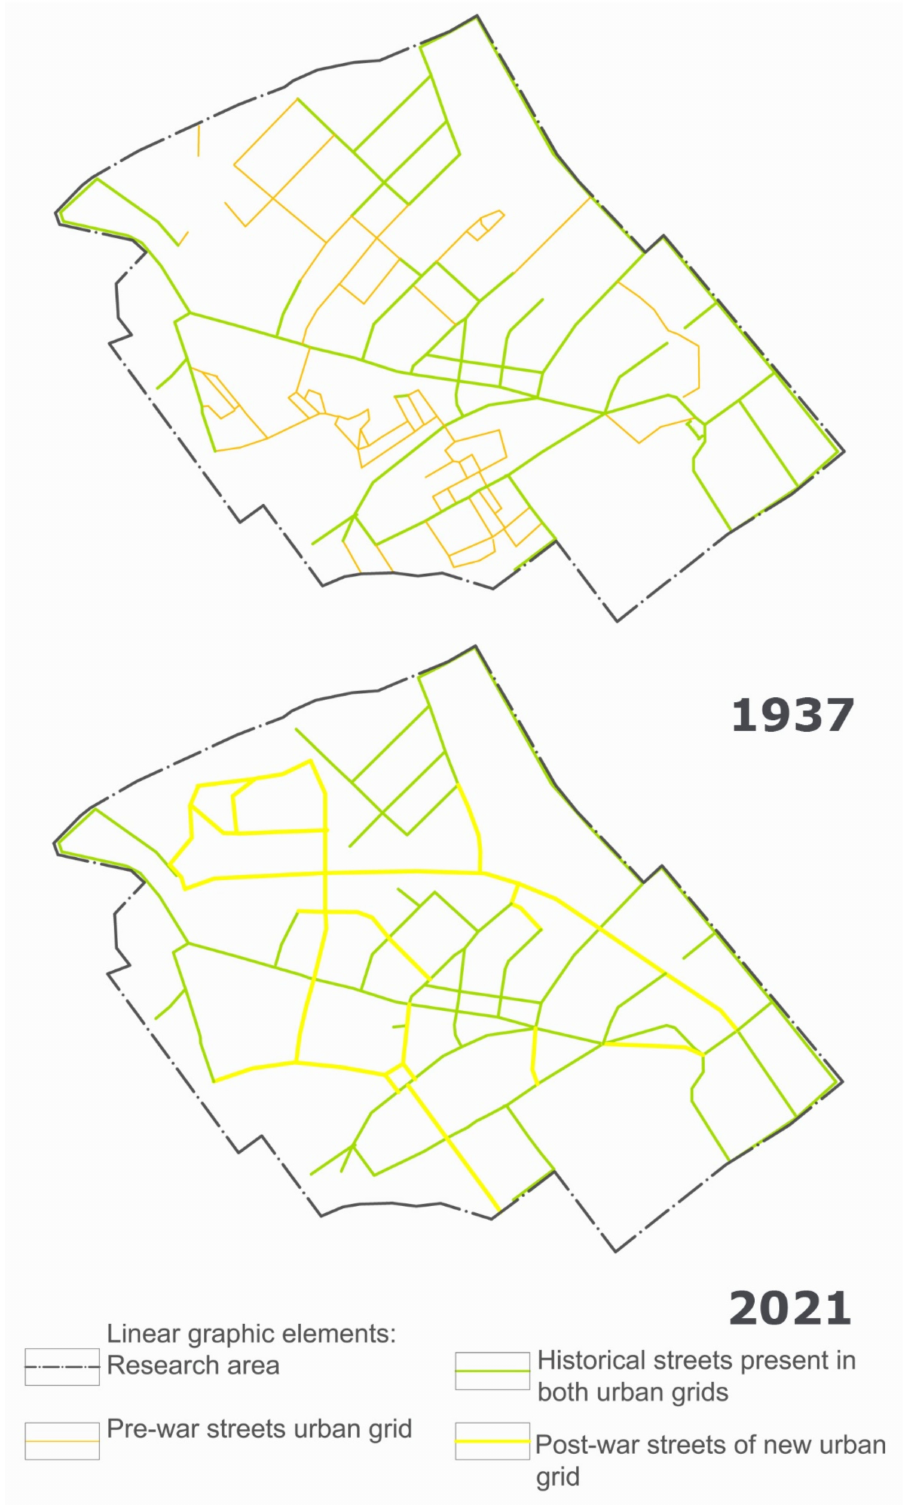
Figure 9. Street network on research area in 1937 and 2021; prepared by M.